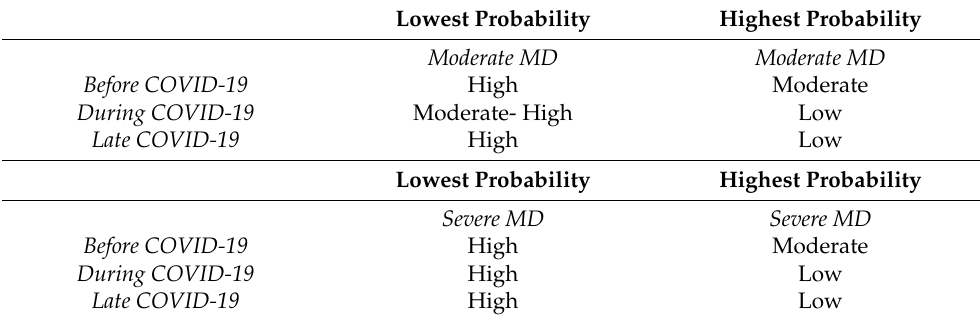
Table 8. Predictive probabilities of moderate and severe mental distress levels by physical exercise frequency and COVID-19 era during weekends.